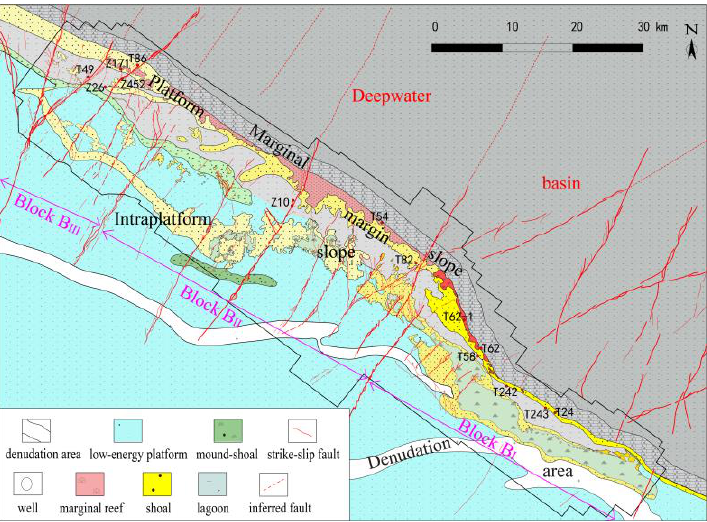
Figure 2. The microfacies of the Lianglitage Formation overlapping with strike-slip fault system in the northern Central Uplift (The microfacies data are from references of [19,22,28], the thrust faults are modified after reference [28], the strike-slip faults are from recent seismic interpretation data).